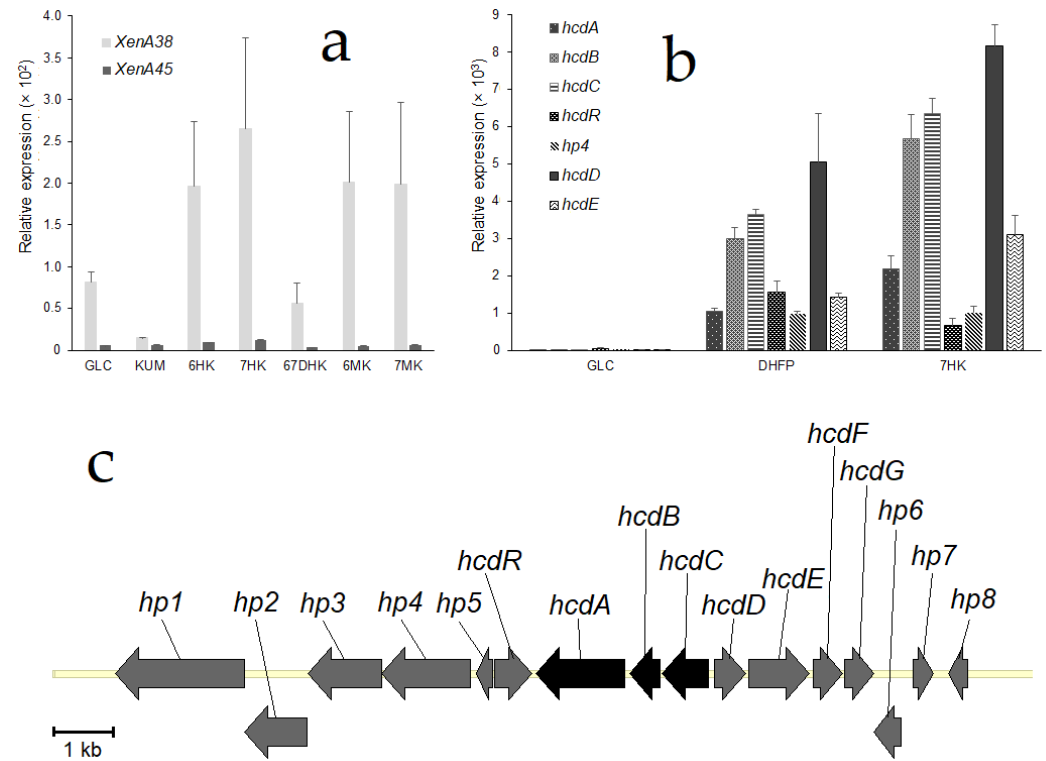
Figure 3. Quantitative RT-PCR analysis of Pseudomonas mandelii 7HK4 transcripts. Strain 7HK4 was cultivated in minimal medium supplemented with either 1 mM coumarin derivative (induced conditions) or glucose (noninduced condition) as a single source of carbon. ( a ) qPCR analysis of the transcription of xenA38 and xenA45 genes. ( b ) qPCR analysis of the transcription of hcdABCR , hp4, hcdD and hcdE genes. Primers were designed to amplify the regions of corresponding genes (Table S3). The data are presented as relative RNA amounts calculated from the threshold cycles using the threshold cycle of 16S RNA as a reference. The averages of three independent runs are presented. GLC—glucose; KUM—coumarin; 6HK—6-hydroxycoumarin; 7HK—7-hydroxycoumarin; 6MK—6-methylcoumarin; 7MK—7-methylcoumarin; 67DHK—6,7-dihydroxycoumarin; DHFP—3-(2,4-dihydroxyphenyl)propionic acid. ( c ) Organization of hcdABC and its adjacent genes in P. mandelii 7HK4 bacteria. The black arrows indicate previously described ORFs encoding HcdA, HcdB, HcdC [18] and grey arrows indicate hcdDEFG genes studied in this work and ORFs encoding hypothetical proteins (hp).